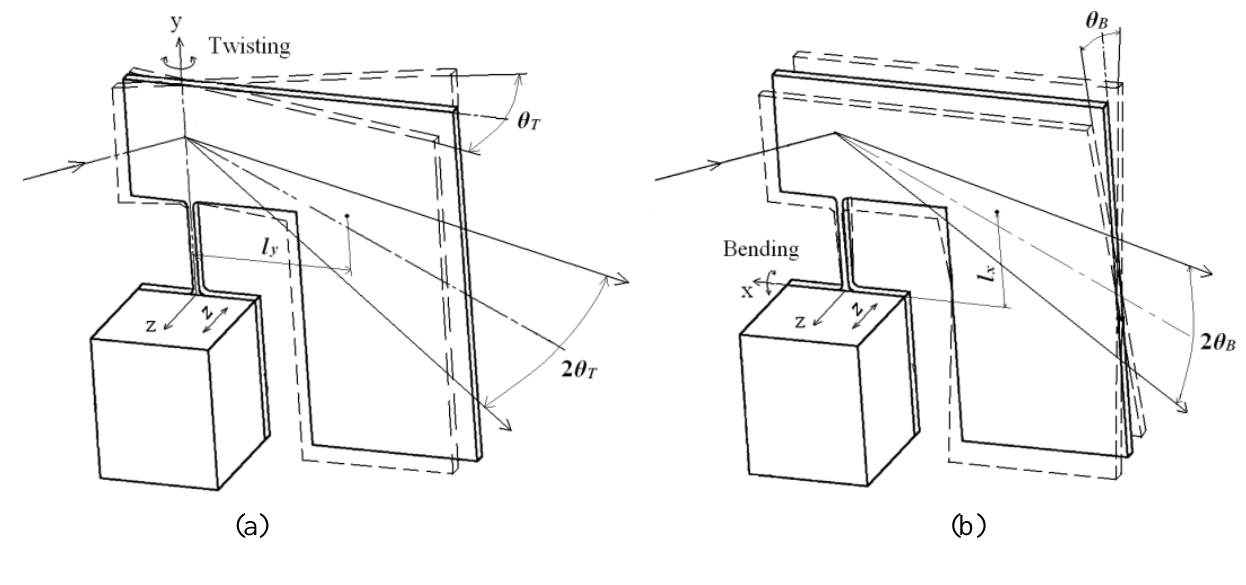
Figure 2. Two resonance vibration modes. (a) twisting around the y-axis, (b) bending around the